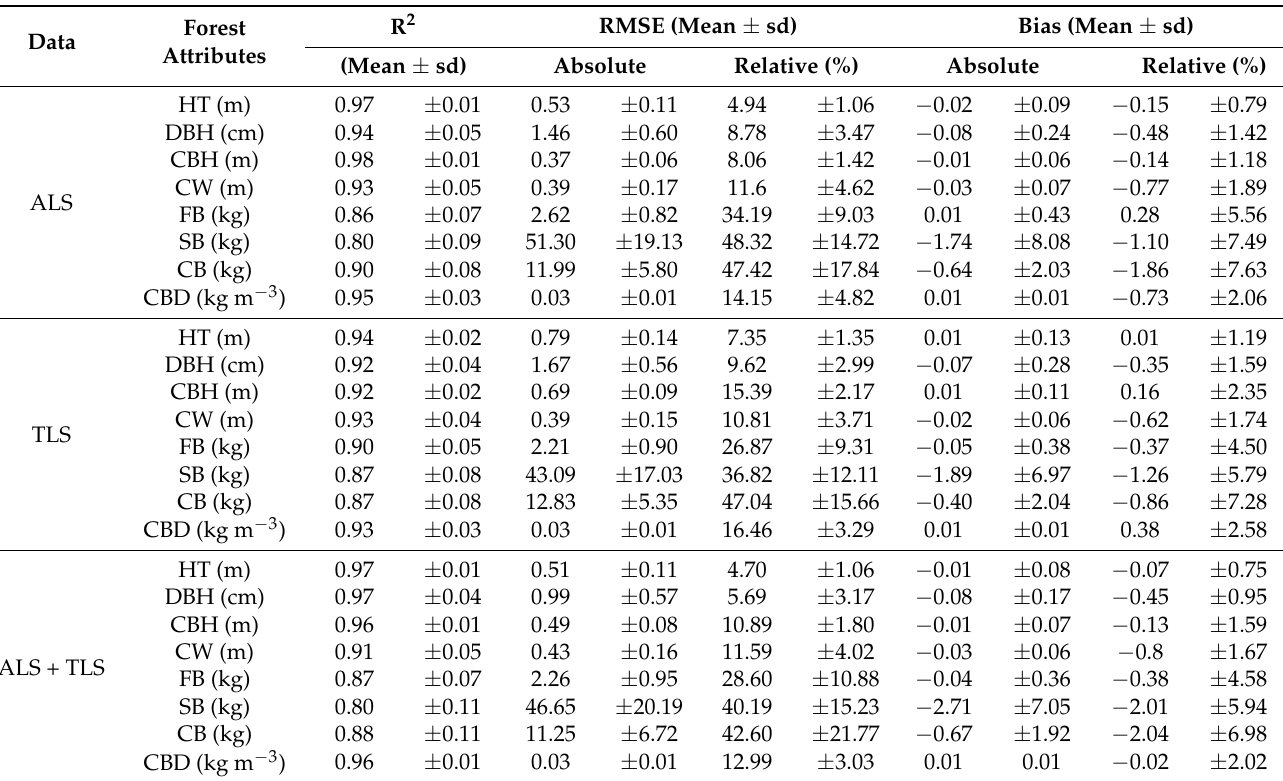
Table 5. Bootstrap prediction accuracies (mean ± sd) from the random forest (RF) models (n = 500) in terms of R 2 , absolute and relative root mean square error (RMSE), and bias. Tree height (HT); Diameter at breast height (DBH); crown width (CW); canopy base height (CBH); foliage biomass (FB); stem branches biomass (SB); crown biomass (CB); crown bulk density